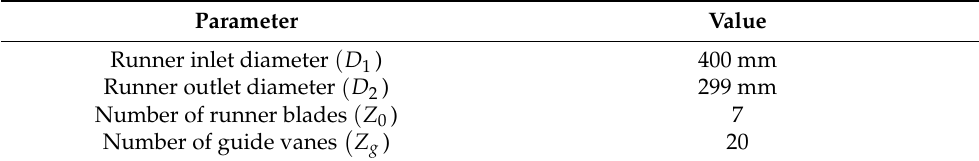
Table 2. Major parameters of the model